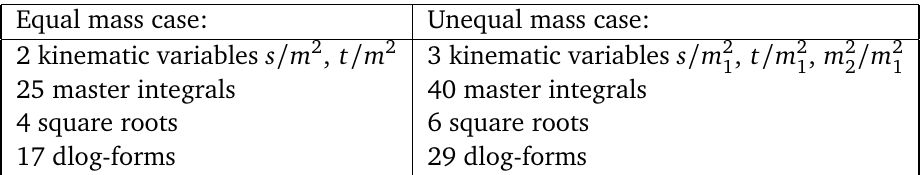
Table 1: The essential numbers for the equal and unequal mass